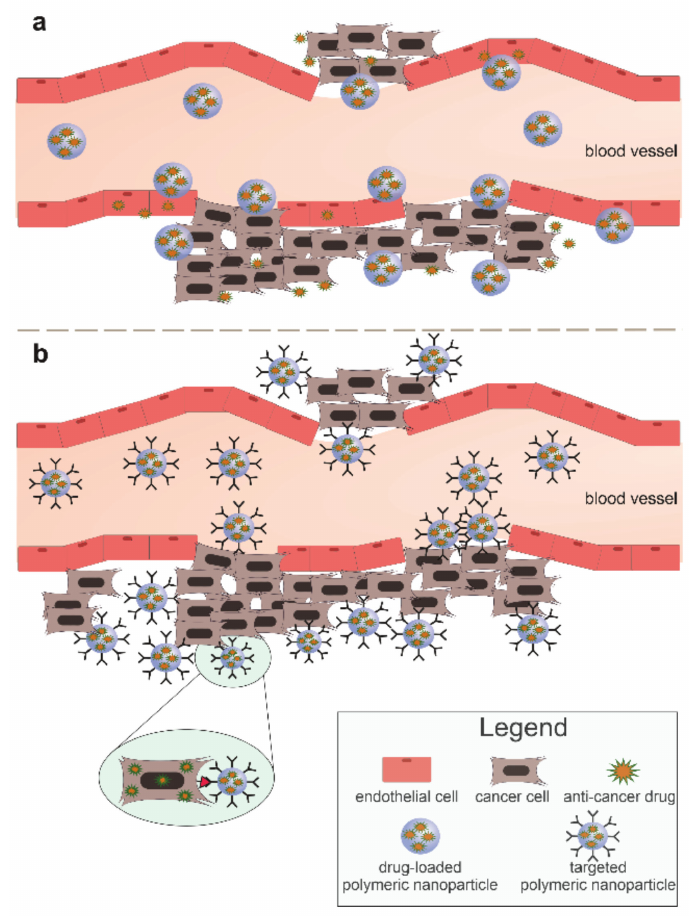
Figure 3. Mechanisms of action of polymeric nanoparticles: ( a ) passive mechanism; ( b ) active